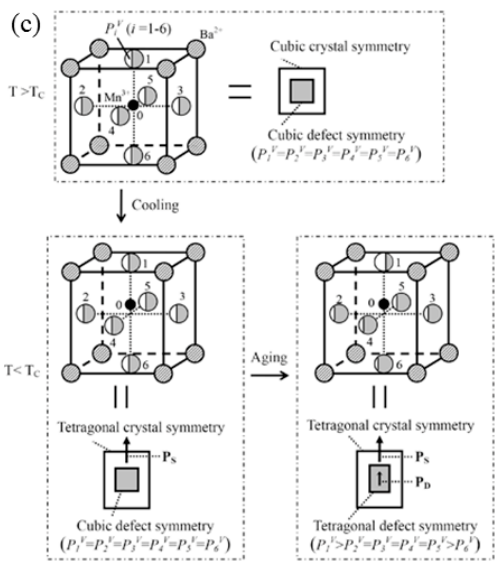
Figure 7. ( a ) Direct evidence for reversible domain-switching process and its relation to a double hysteresis loop in aged Mn-BaTiO 3 single-crystal sample. ( b ) Its comparison to an unaged specimen. ( c ) Based on the observation, the mechanism is given regarding defect symmetry and related crystal symmetry in a perovskite BaTiO 3 structure doped with Mn 3+ ions at Ti 4+ sites [42]. 4. Large Piezoelectric Response Caused by Morphotropic Phase Boundary in BaTiO 3